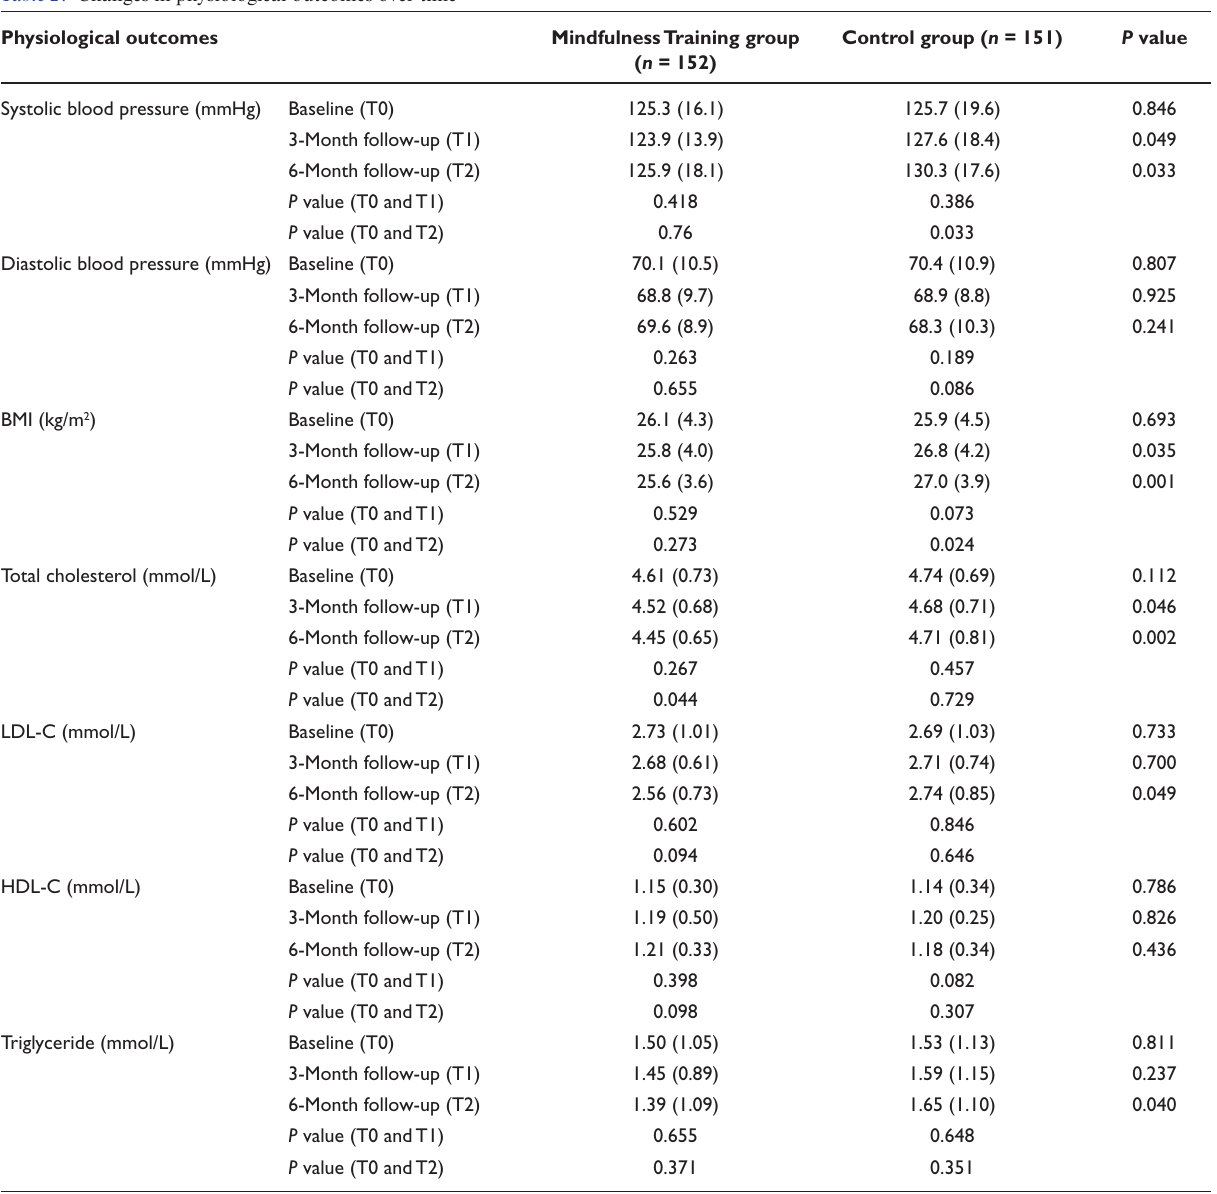
Table 2 . Changes in physiological outcomes over time Physiological